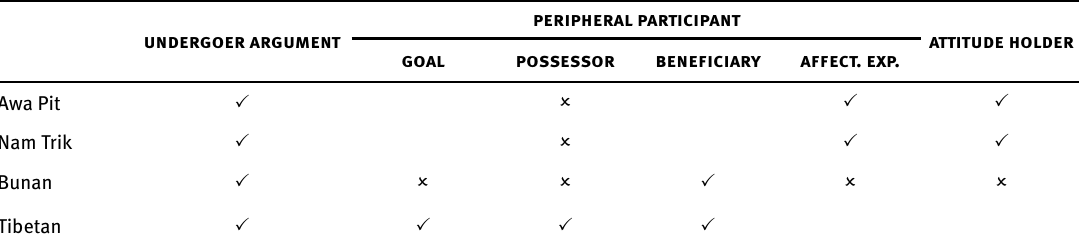
attitude holder